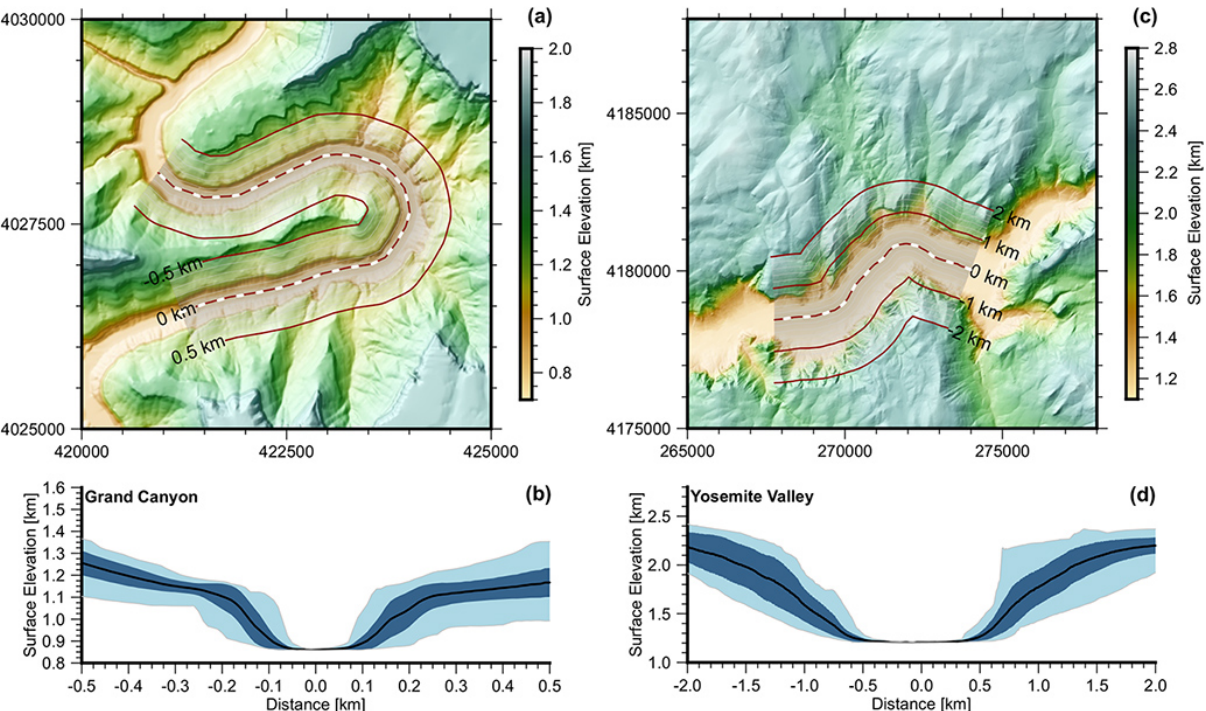
Figure 3. Fluvially versus glacially eroded valleys. The maps show sections of (a) the Colorado River formed by fluvial incision and (c) the Yosemite Valley shaped by glacial scouring. Constant distance lines are red, only the baseline is dashed red and white. The pale region covers all values included in the swath profiles shown in (b) and (d) . Mean elevation (black line), extreme values (hull of the blue area) and mean elevation ± 1 standard deviation (hull of the dark blue area) are plotted. Bin width is 10m. Maps and swath profiles were derived from the National Elevation Dataset in the UTM (Universal Transverse Mercator) coordinate system with a spatial resolution of 10m (Gesch et al.,